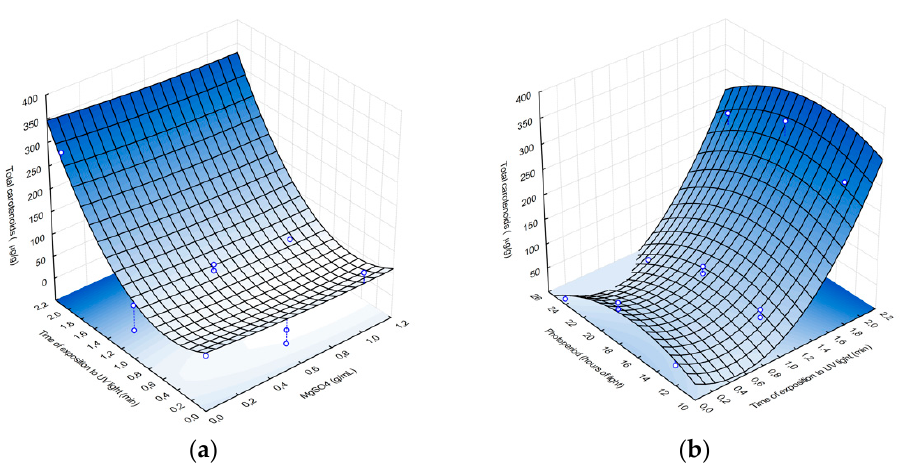
Figure 1. Effect of MgSo 4 vs. UV exposure ( a ) and photoperiods vs. UV exposure ( b ) on carotenoid production.